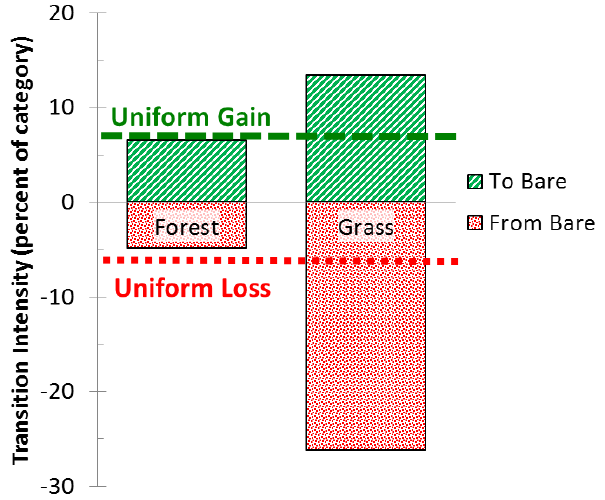
Figure 6. Intensity of transitions given Bare’s gain on the positive axis and given Bare’s loss on the negative